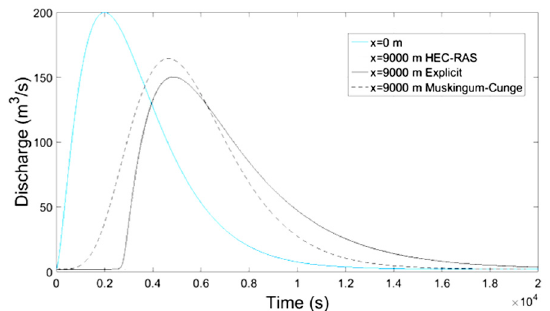
Figure 8. Discharge-Time at x = 9000 m.